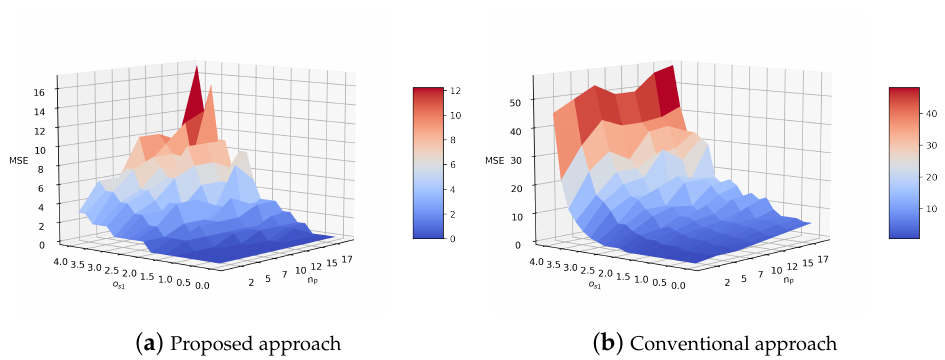
Figure 15. MSE with different observation noise and the number of prediction steps between